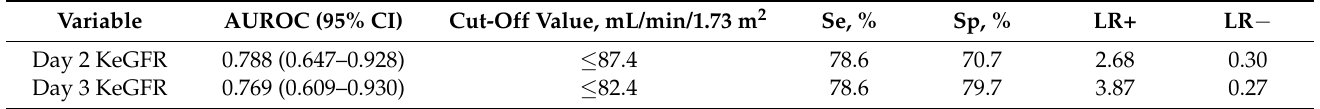
Table 6. Diagnostic accuracy of day 2 and day 3 KeGFR in prediction of severe acute pancreatitis (SAP). Variable AUROC (95%